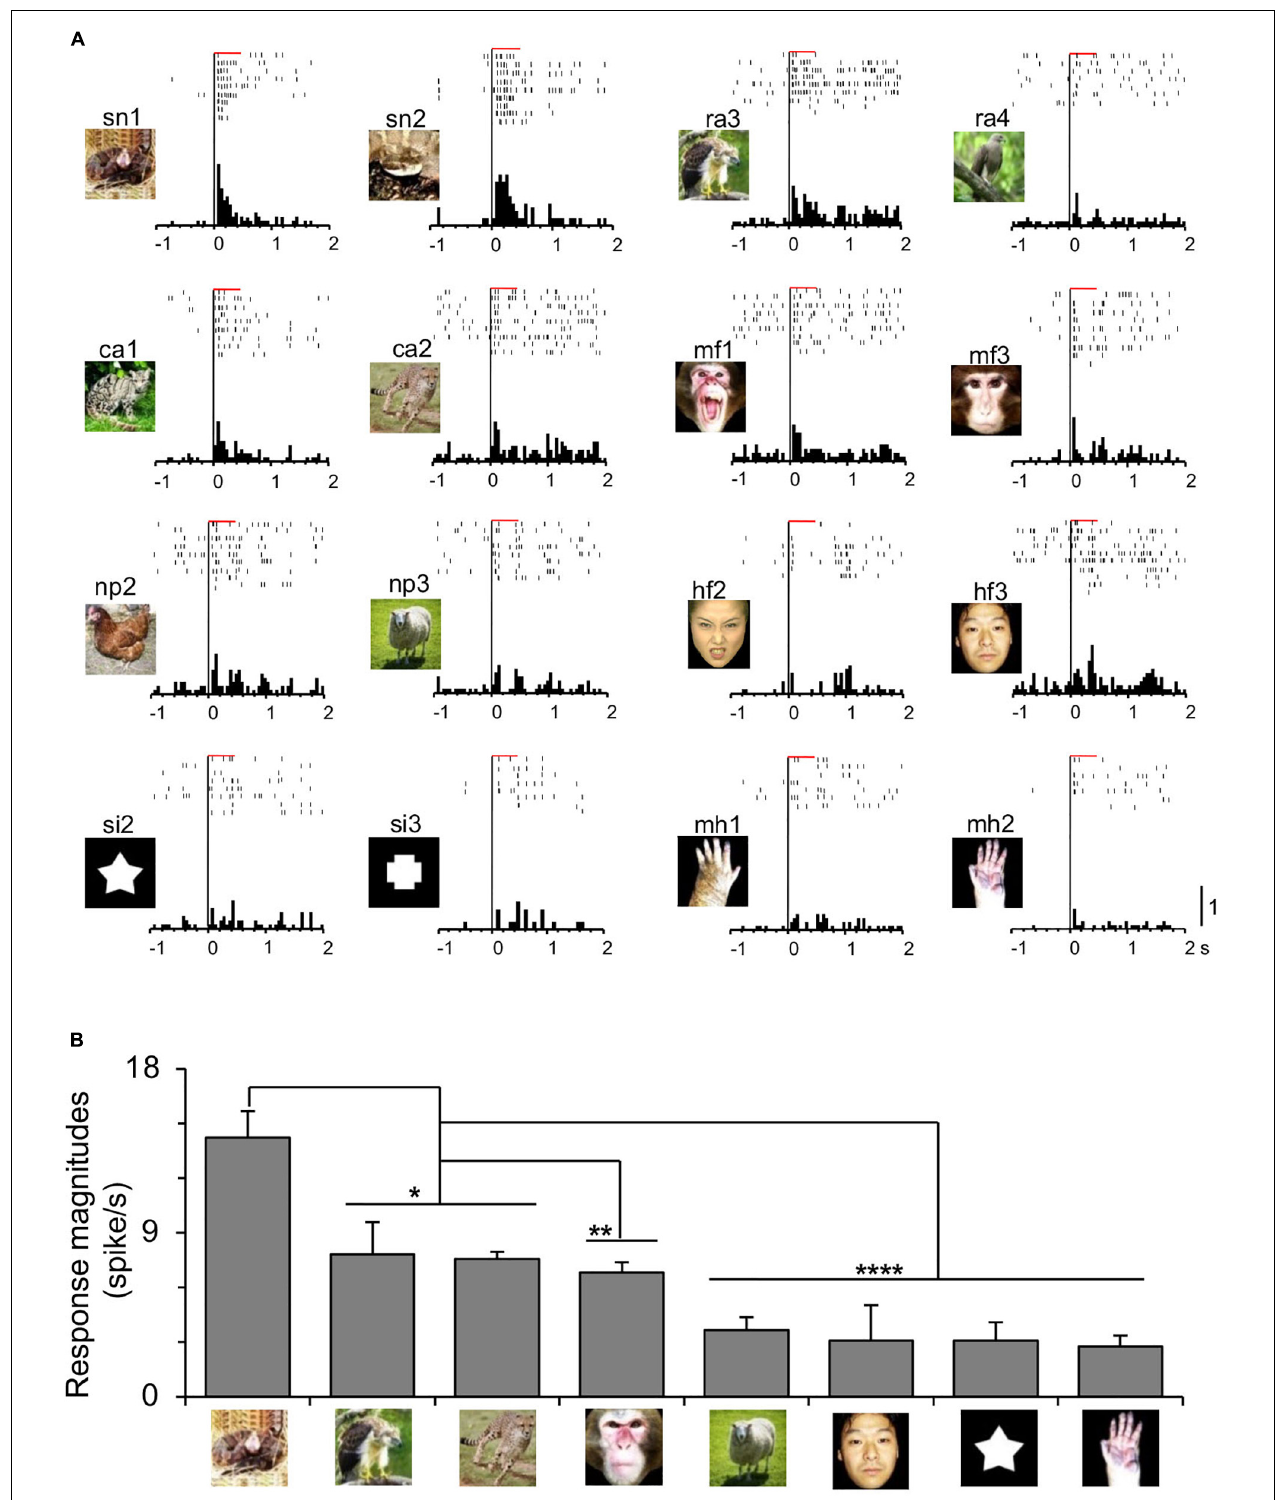
FIGURE 2 | Neuronal responses of a snake-responsive amygdalar neuron. (A) Neuronal responses to each indicated stimulus are shown by raster displays and their summed histograms. Horizontal red bars above the raster displays, stimulus presentation periods (500 ms); bin width of histograms, 50 ms; calibration at the right bottom of the figure, number of spikes per trial in each bin. (B) Comparison of response magnitudes of the neuron shown in (A) to the eight categories of the visual stimuli. ****, **, *, p < 0.0001, 0.01, 0.05, respectively (Tukey test after one-way ANOVA). Copyright: ATR-Promotions, republished with permission.